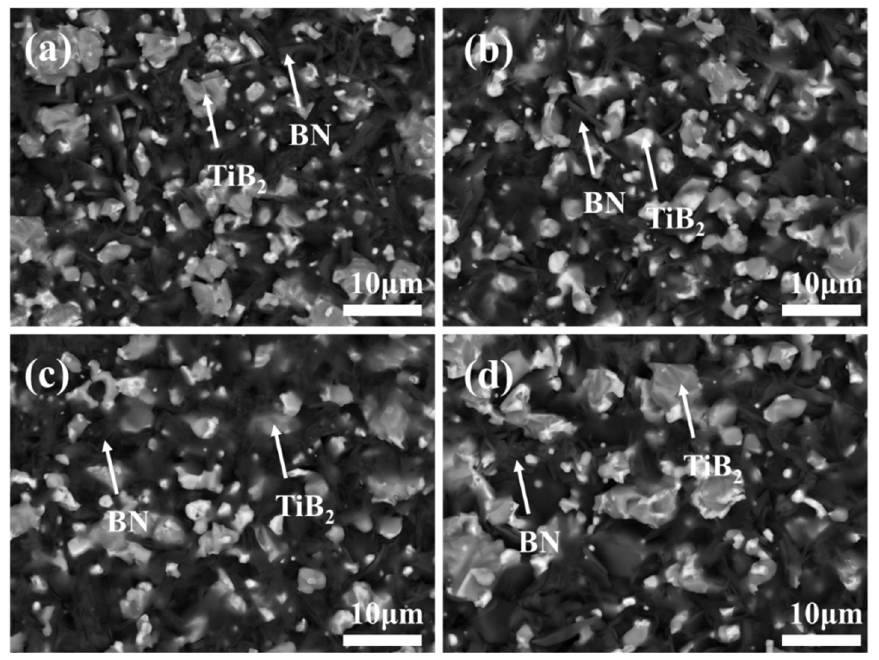
Figure 9. BSE images of TiB 2 -BN-SiC composite ceramics at four sintering temperatures: ( a ) 1650 °C, ( b ) 1750 °C, ( c ) 1850 °C, and ( d ) 1950 °C.